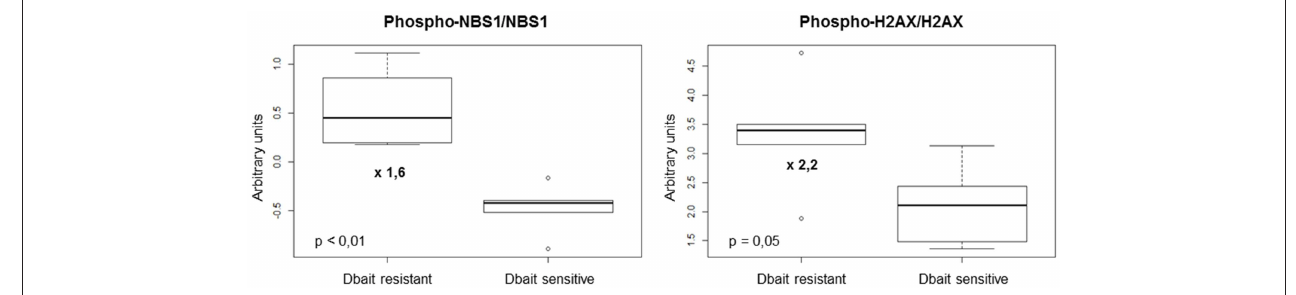
FIGURE 5 | Markers involved in Dbait treatment resistance. We analyzed a total of 88 proteic markers (see Table S1 ) to explore tyrosine kinase signaling, SAPK/JNK signaling, stress signaling, DNA repair, PI3K pathway, apoptosis, cell cycle, adhesion/cytoskeleton, MAPK/ERK signaling and NF κ B signaling. Data obtained for 11 models (without any treatment) were analyzed with 6 replicates for each xenograft models to identify makers that can predict resistance to Dbait treatment. A Mann-Whitney test was performed ( p < 0.05) between the two groups of models (sensitive and resistant to Dbait